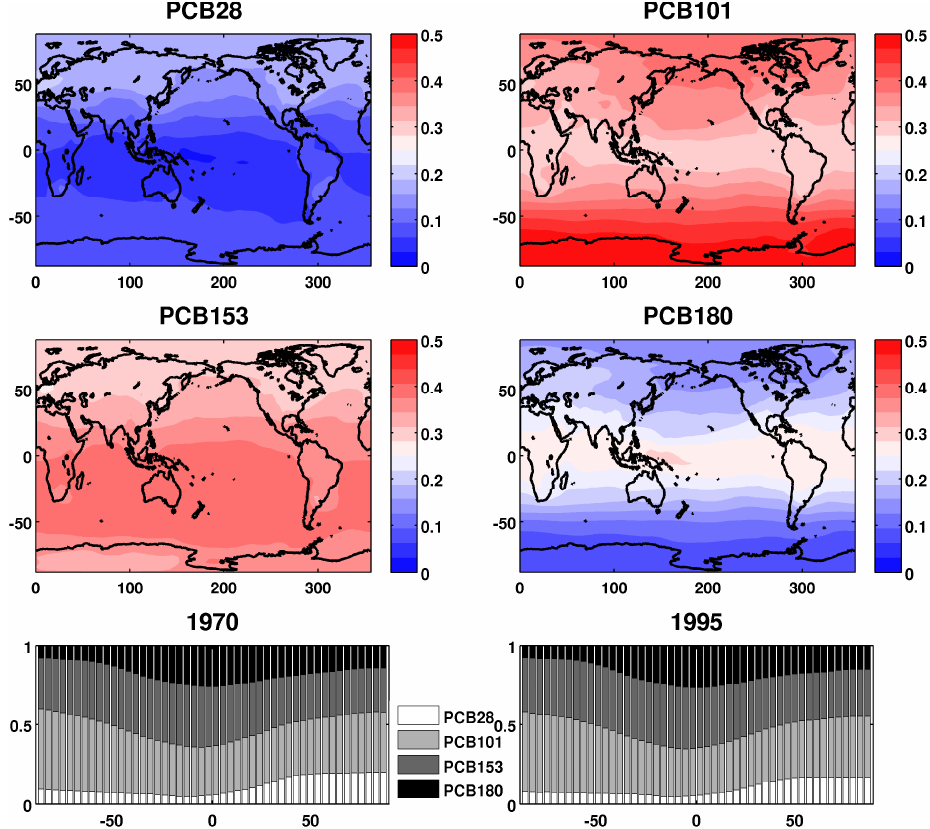
Fig. 5. Fractionation: Geographic (mean of year 1995, upper two panels) and meridional (mean of years 1970 and 1995, lower panel) distributions of the fraction (between 0 and 1) of the individual congener’s burden in the mixture of four PCB congeners’ burdens in the atmosphere.